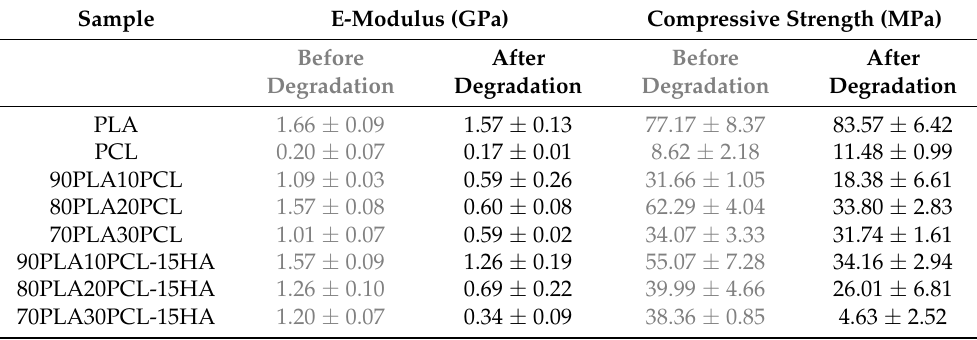
Table 6. E-modulus and compressive strength obtained for all materials before (grey, repeated from Table 4) and after (black) 28 days of degradation. Sample E-Modulus (GPa) Compressive Strength (MPa) Before After Before After Degradation Degradation Degradation